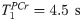
Simulated Mo/Mss (under fully relaxed conditions) and Mc/Ms ratio vs kf for creatine kinase reaction showing linear relationship and same intercept.The parameters for simulation were: flip angle = 90°, TR = 2.8 s, Tsat = 1.8 s, PCr:ATP = 2.0, T1PCr=4.5s and T1ATP=1.8s. T1nom determined for these spin parameters is 1.9 s.